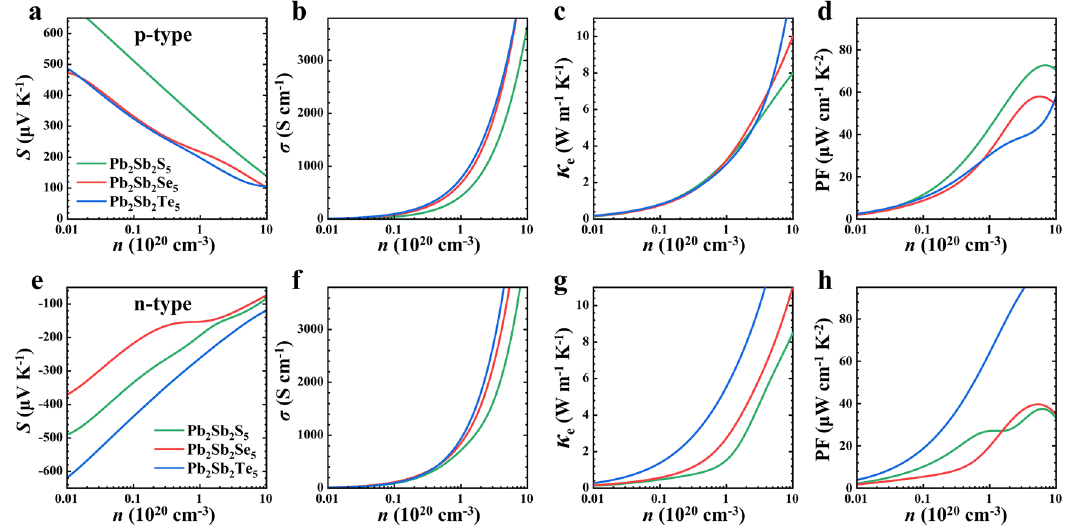
Fig. 7 Electronic transport properties analysis. a – d P-type and e – h n-type electronic transport properties of three Pb 2 Sb 2 VI 5 compounds as a function of carrier concentration ( n ) at 650 K: a , e Seebeck coef fi cient S , b , f electrical conductivity σ , c , g electronic thermal conductivity κ e , and d , h power factor PF.